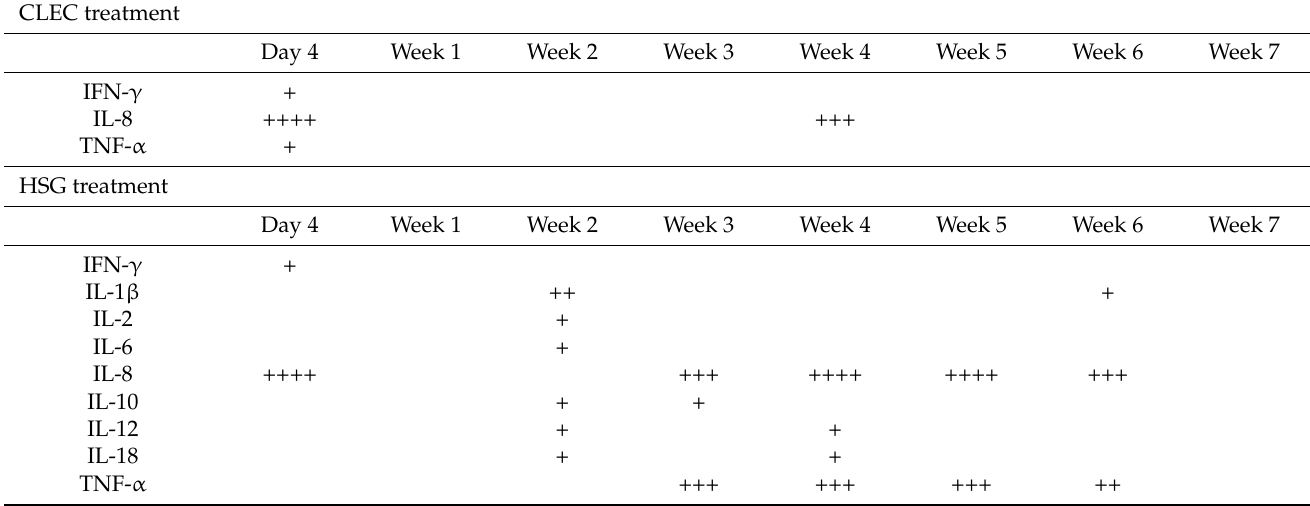
Table 4. Fold change increase of probed inflammatory cytokine concentrations in porcine blood serum from the pre-procedure baseline level; only cytokines with a fold change of two and above are reflected in the